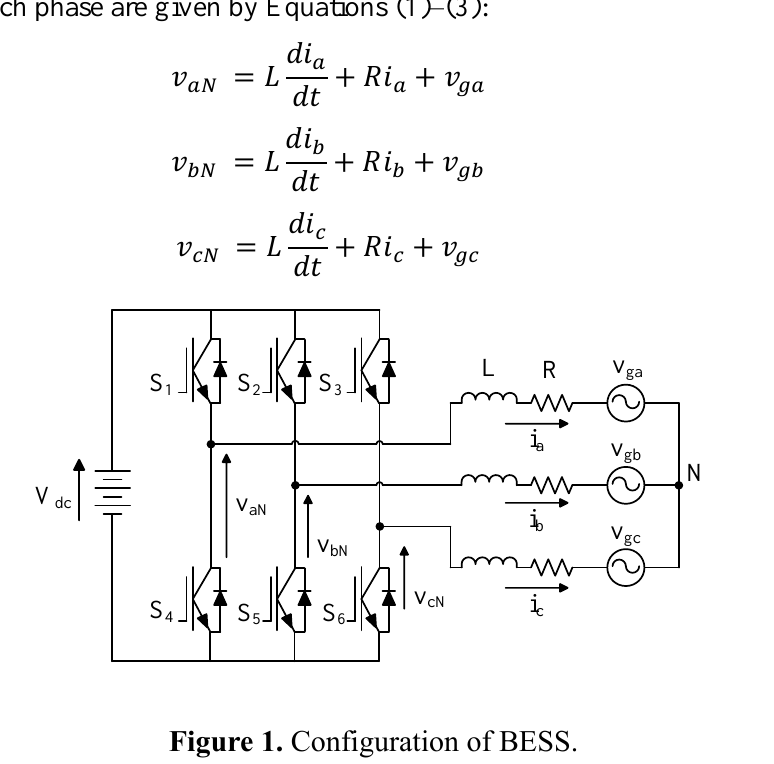
Figure 1. Configuration of